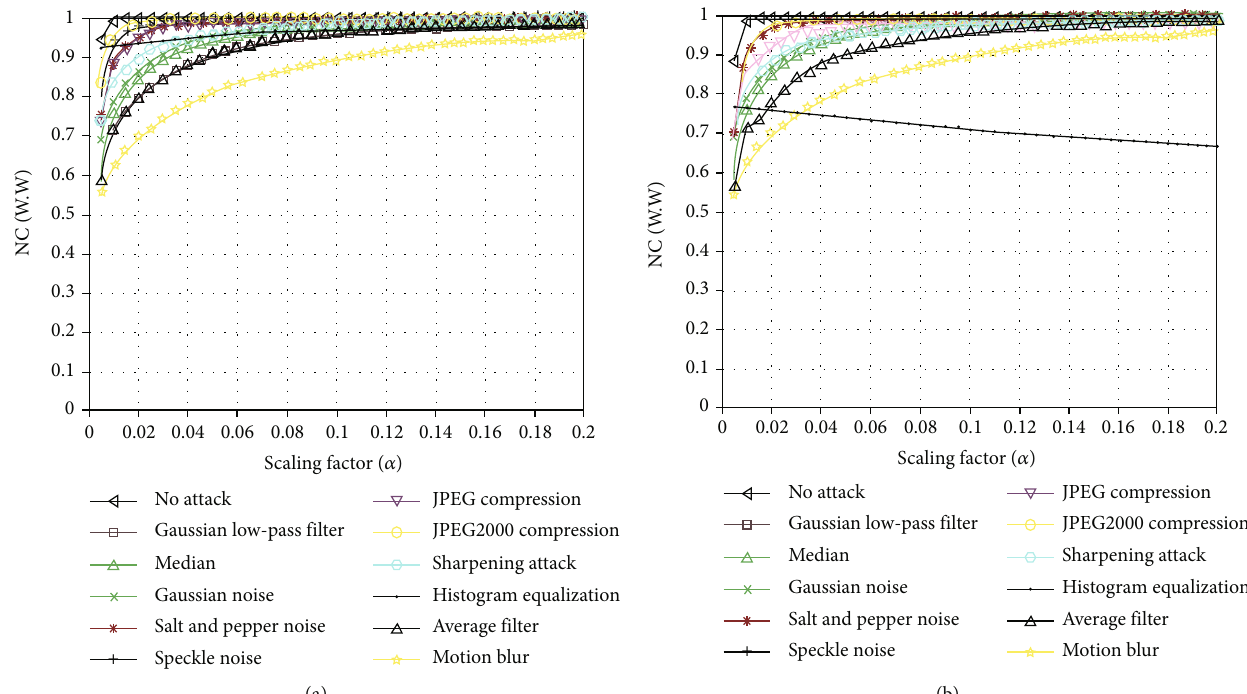
Figure 5: Scaling factors of various parameters by using NC: (a) lion image and (b) Elaine